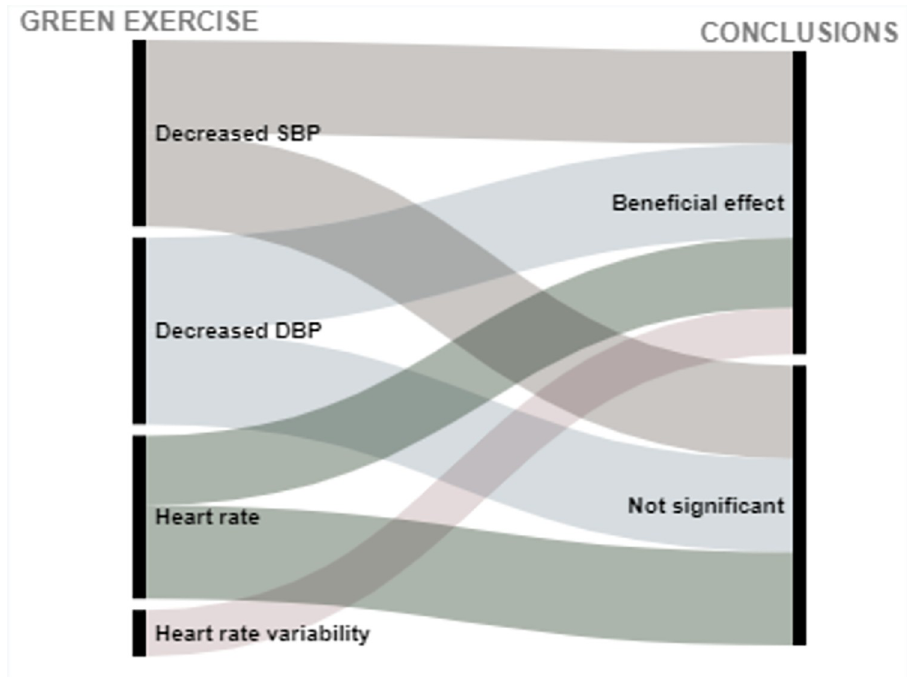
Fig 5. Green exercise intervention effects on CV health outcomes: Trends of associations among all statistical tests conducted. The first column represents outcome measures while the second column represents summary conclusions in terms of protective effects (beneficial effect) or no significant results (not significant). Acronyms : SBP 1 : Systolic blood pressure and DBP 2 : Diastolic blood pressure.